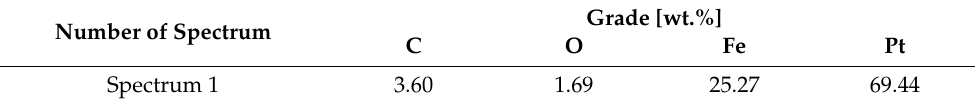
Table 10. The elemental composition of the spectrum for the samples shown in Figure 16.